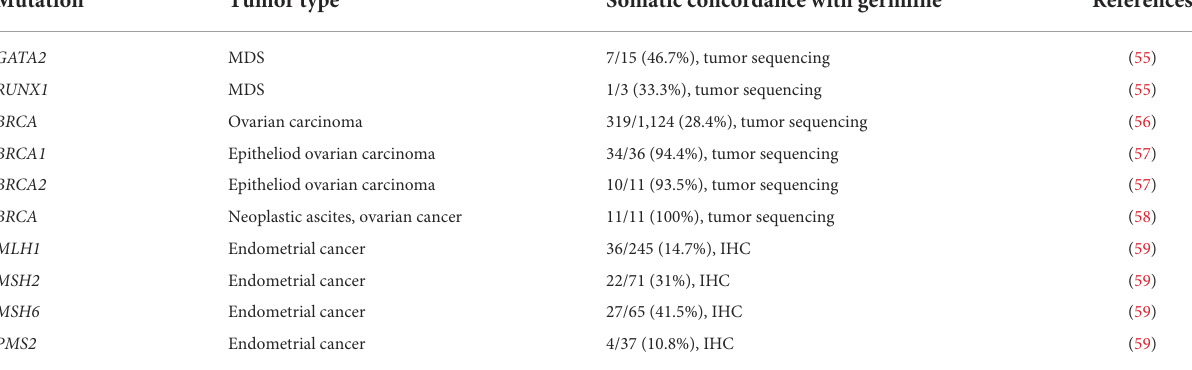
TABLE 4 Somatic-germline mutation